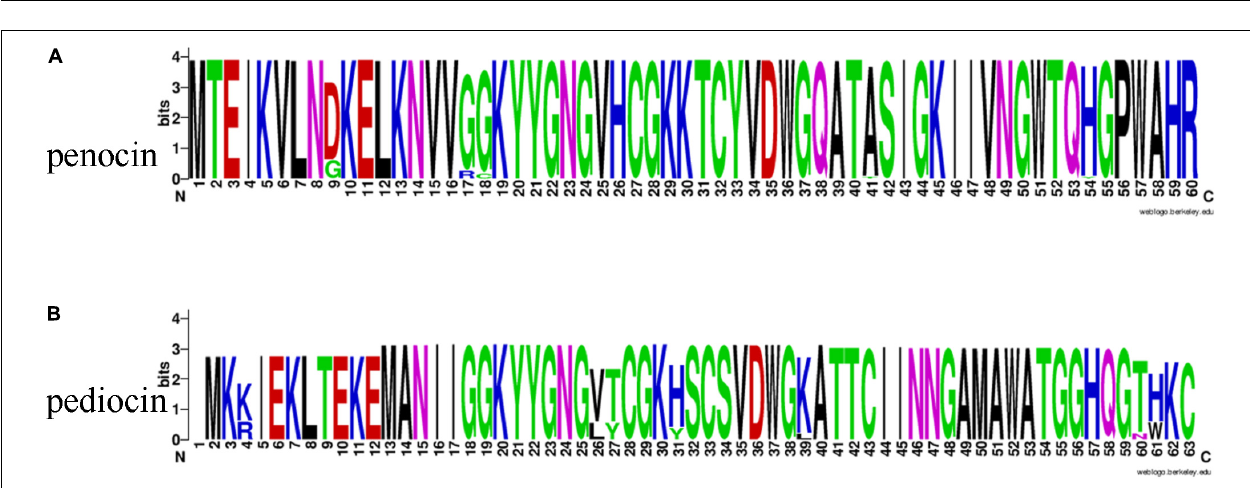
FIGURE 11 | Putative operons for the predicted bacteriocin in P. pentosaceus. TR, transcriptional regulator.